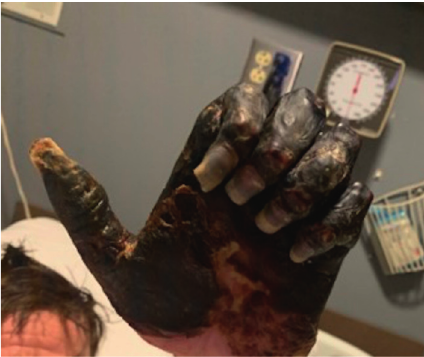
Figure 3: Progression of gangrene 10 days after initial presentation.